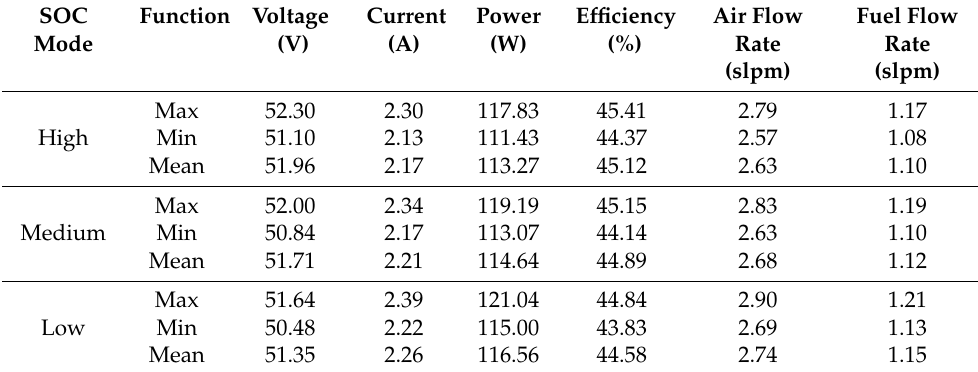
Table 4. FC response in high, medium and low SOC passive hybrid simulation.